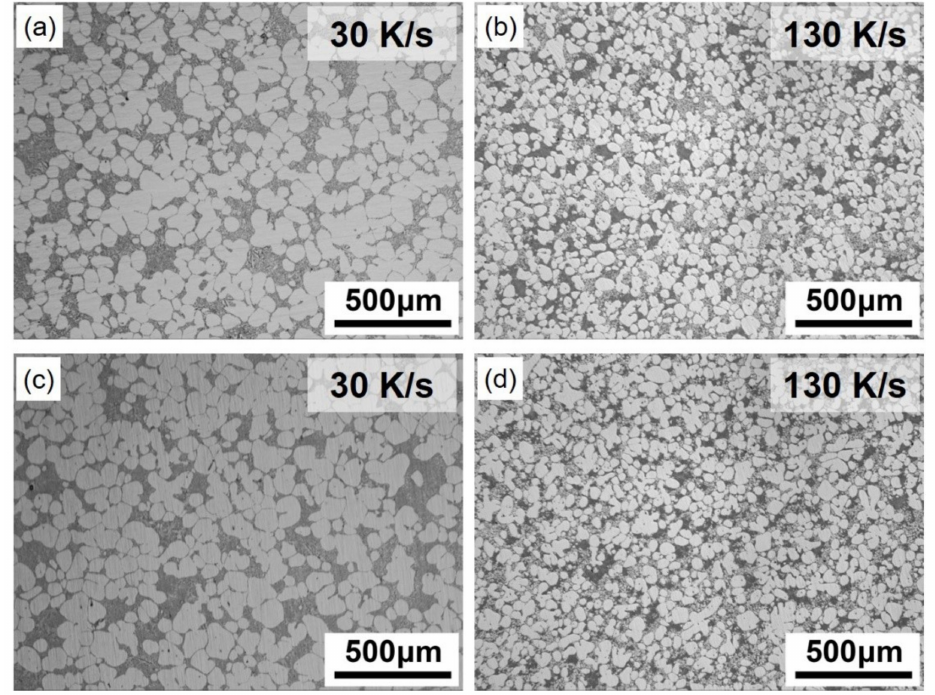
Figure 9. Microstructure showing the α -Al grains in ( a , b ) Al7SiMg and ( c , d ) Al7SiMg + 0.4La alloys at the cooling rate of 30 and 130 K / s.